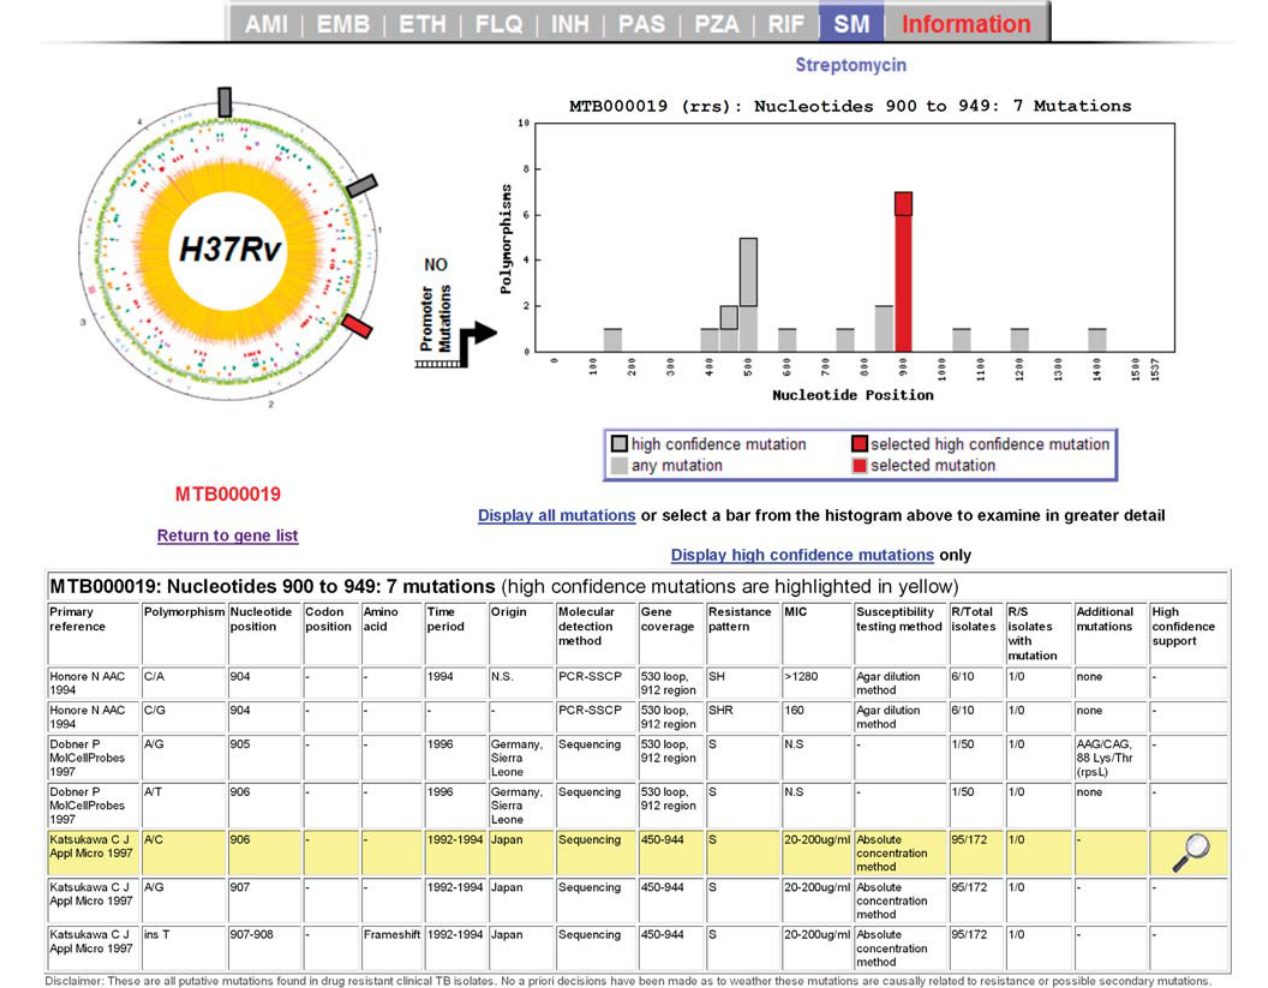
Figure 1. Part of the Interface of the Web